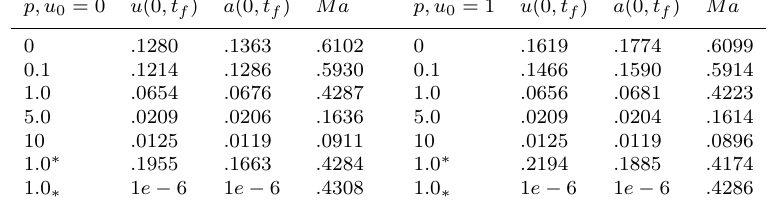
Table 3. The values of u (0 ,t f ) , a (0 ,t f ) and Ma -maximal value of a ( z,t ) depending on p p,u 0 = 0 u (0 ,t f ) a (0 ,t f ) Ma